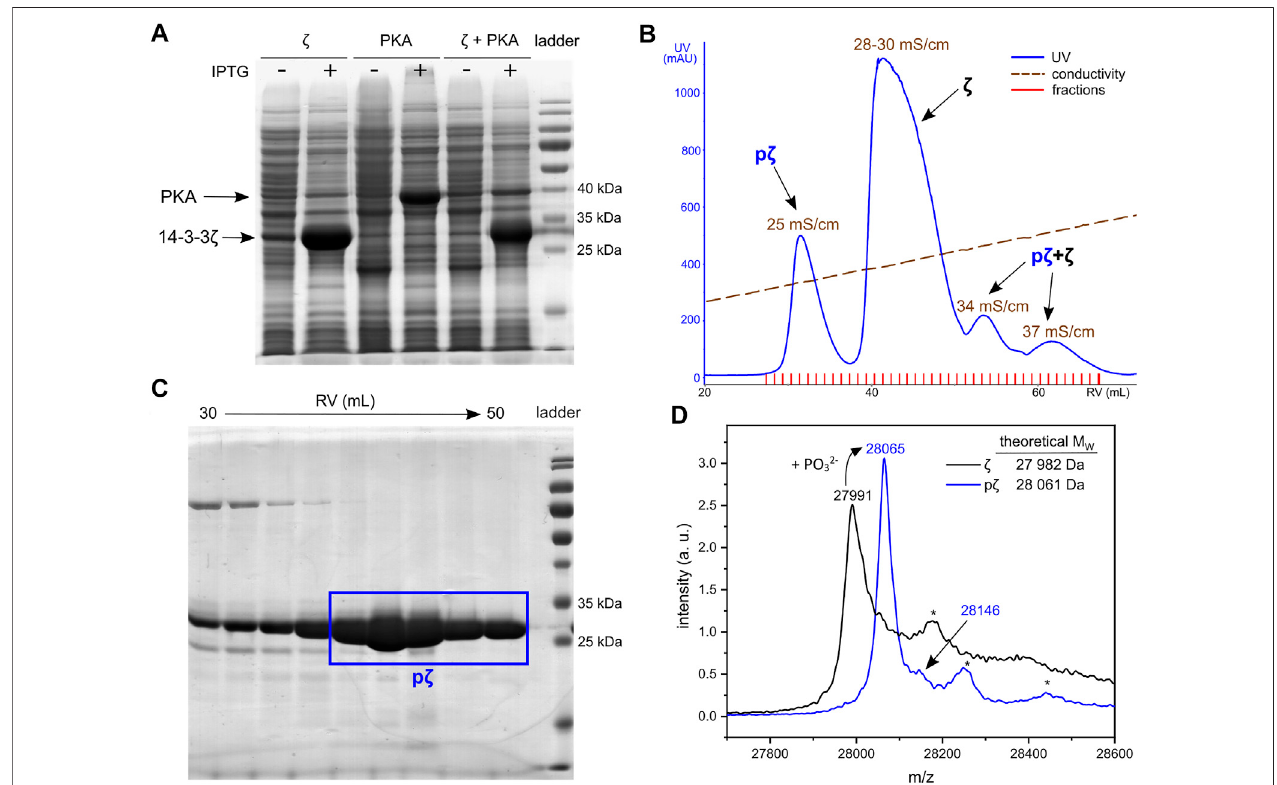
FIGURE1 | Expression and puri fi cation ofp ζ . (A) SDS-PAGE analysisof 14-3-3 ζ and PKA co-expression.Cultures without ( − ) and with (+) induction withIPTG are shown. (B) Chromatogram of AEX elution. Average conductivity characterizing the eluted peaks is highlighted. (C) SDS-PAGE analysis of the SEC puri fi cation step. Fractions corresponding to the fi nal p ζ sample are depicted in a blue rectangle. (D) MALDI-TOF MS spectrum of puri fi ed ζ (in black) and p ζ (in blue). Asterisk denotes a protein adduct with the MALDI matrix (ferulic acid, +176).